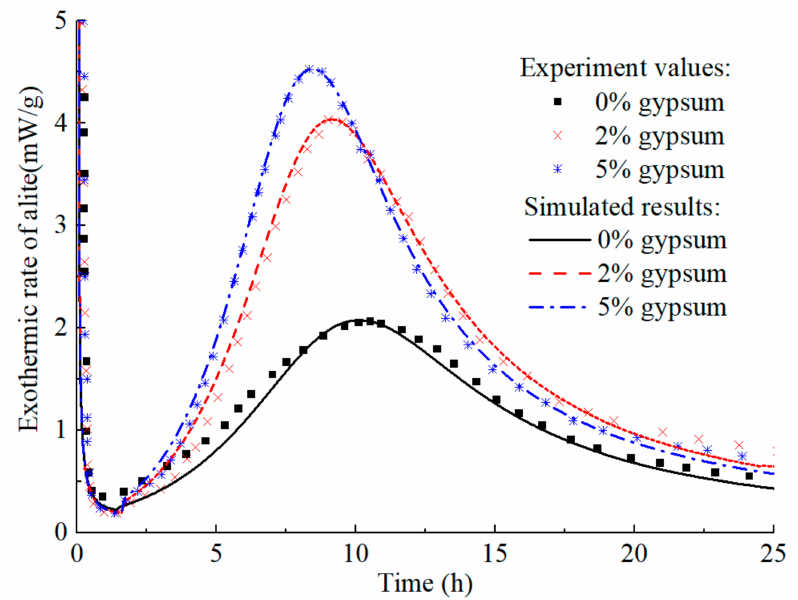
Figure 19. Heat release rate of alite in the alite-gypsum system with different gypsum content (w/c =